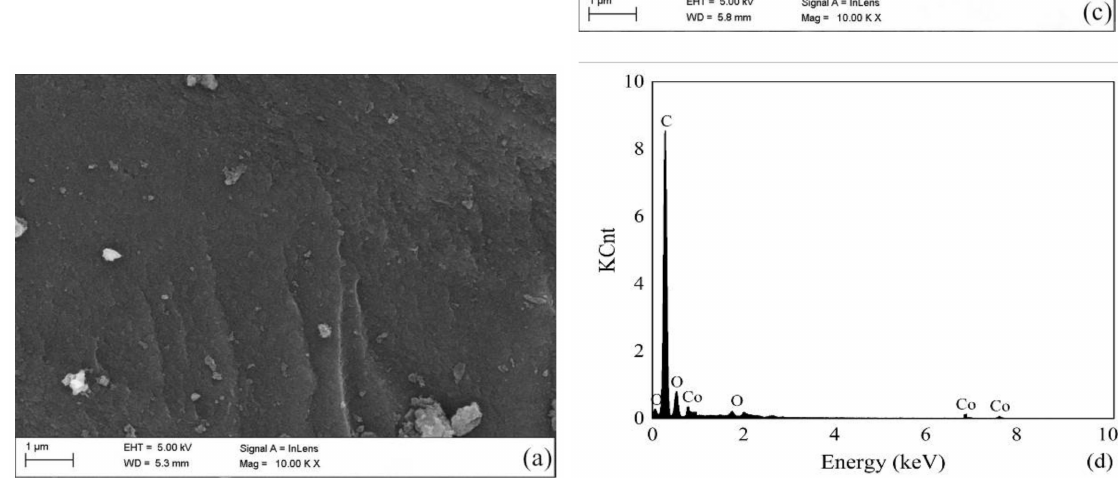
Figure 2. Material characterization: ( a ) SEM image of AC, ( b ) SEM image of Co@AC calcined for 2.0 h, ( c ) SEM image of Co@AC calcined for 4.0 h, ( d ) EDS image of Co@AC calcined for 4.0 h. (The preparation conditions of Co@AC: Co 2+ mass fraction 7.0%, immersing time 7.0 h, calcining temperature 500 ◦